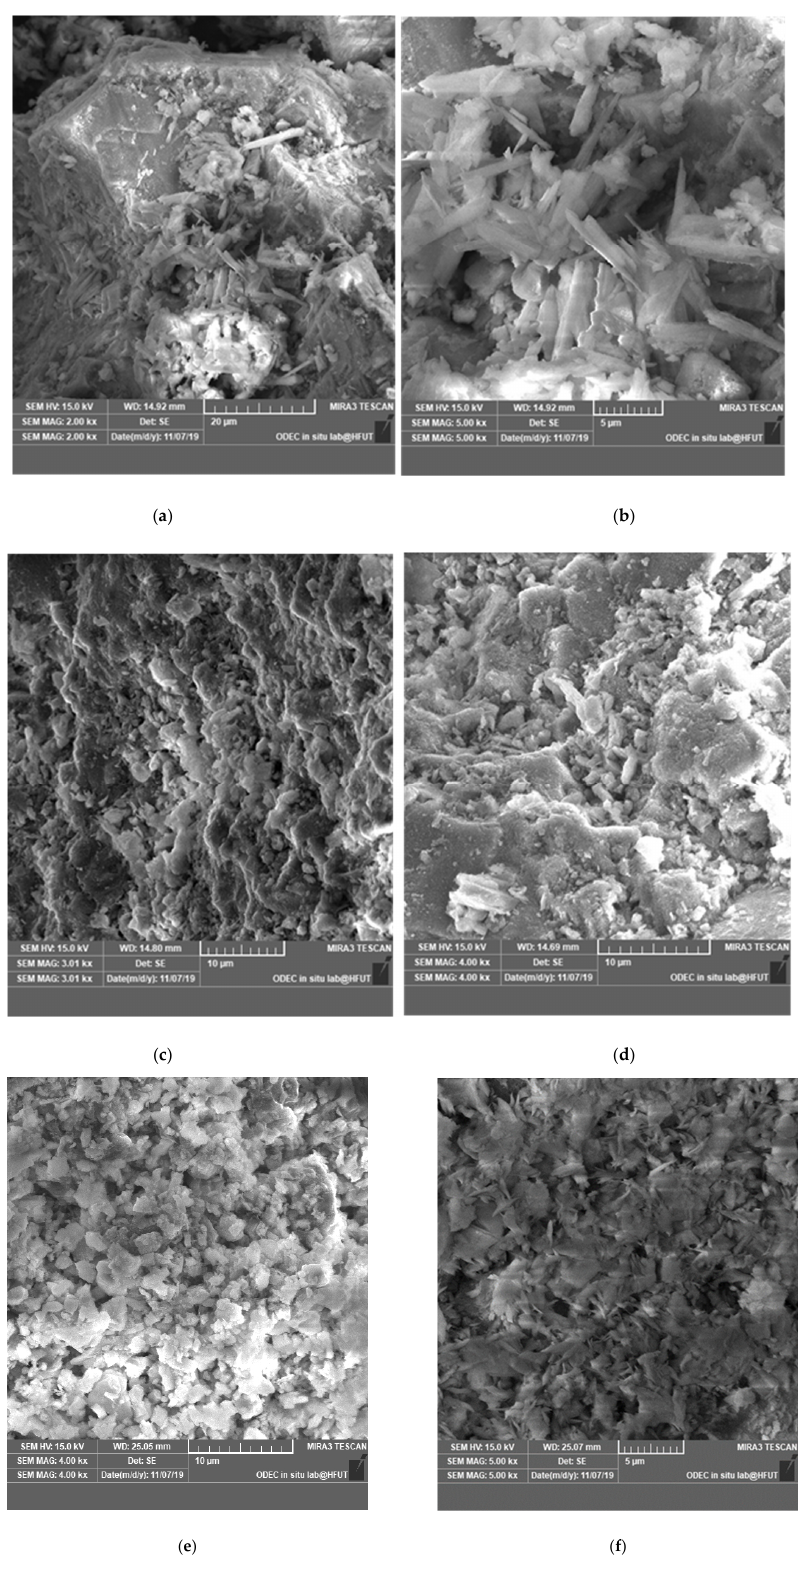
Figure 5. SEM images of A5 ( a , b ), B5 ( c , d ), and C3 ( e , f ). (a) Sample A5 magnified 2000 times; (b) Sample A5 magnified 5000 times; (c) Sample B5 magnified 3000 times; (d) Sample B5 magnified 4000 times; (e) Sample C5 magnified 4000 times; and (f) Sample C5 magnified 5000 times. ( b ) Sample A5 magnified 5000 times; ( c ) Sample B5 magnified 3000 times; ( d ) Sample B5 magnified 4000 times; ( e ) Sample C5 magnified 4000 times; and ( f ) Sample C5 magnified 5000